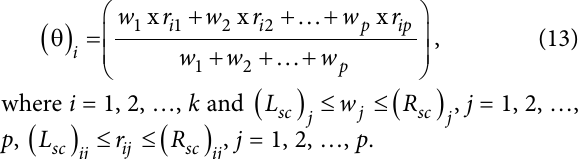
for the attribute in terms of upper bound value is ex- pressed as below in Eqn (13). Table 11 shows the lower and upper bound values for the attributes.